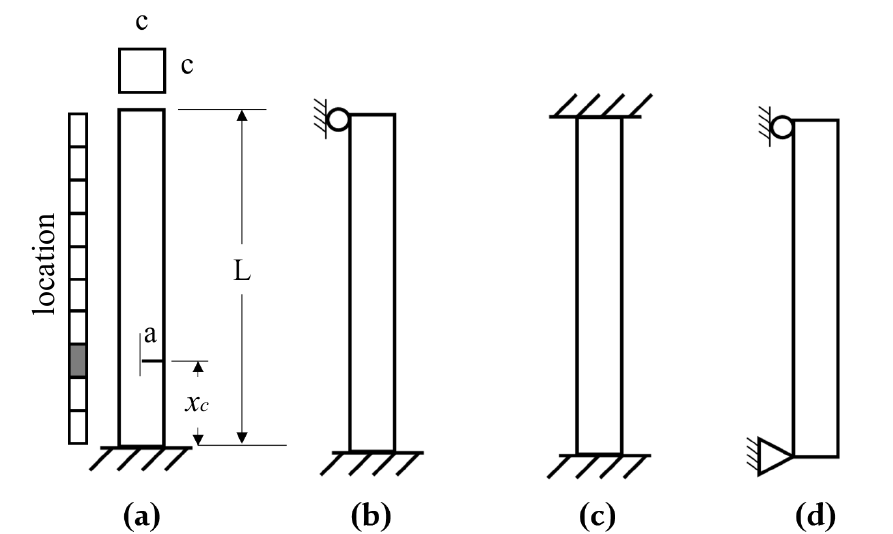
Figure 3. Illustration of different boundary conditions: ( a ) Cantilever beam; ( b ) cantilever, simply supported beam; ( c ) fixed-fixed beam; ( d ) simply supported